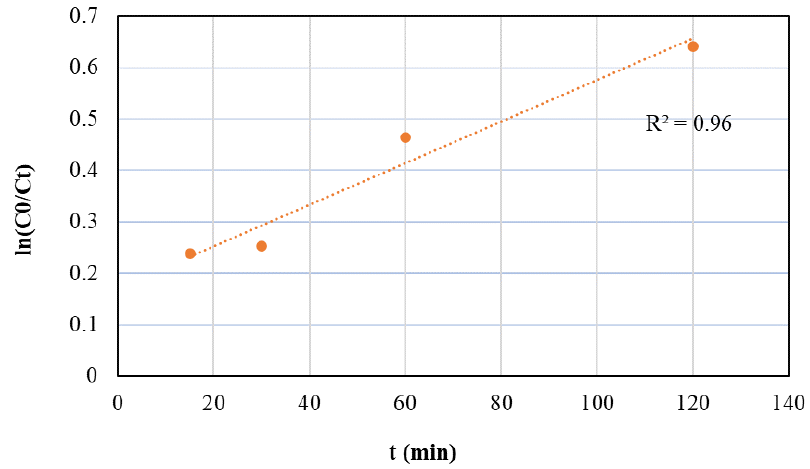
Figure 11. Pseudo-first-order kinetics of ODS runs with HPMo/Ti-TUD-1(0.025) catalyst; cata- lyst/feed ratio = 0.05; T = 70 °C; oxidant, 30% H 2 O 2 ; H 2 O 2 /S = 10; and stirring = 550 rpm.